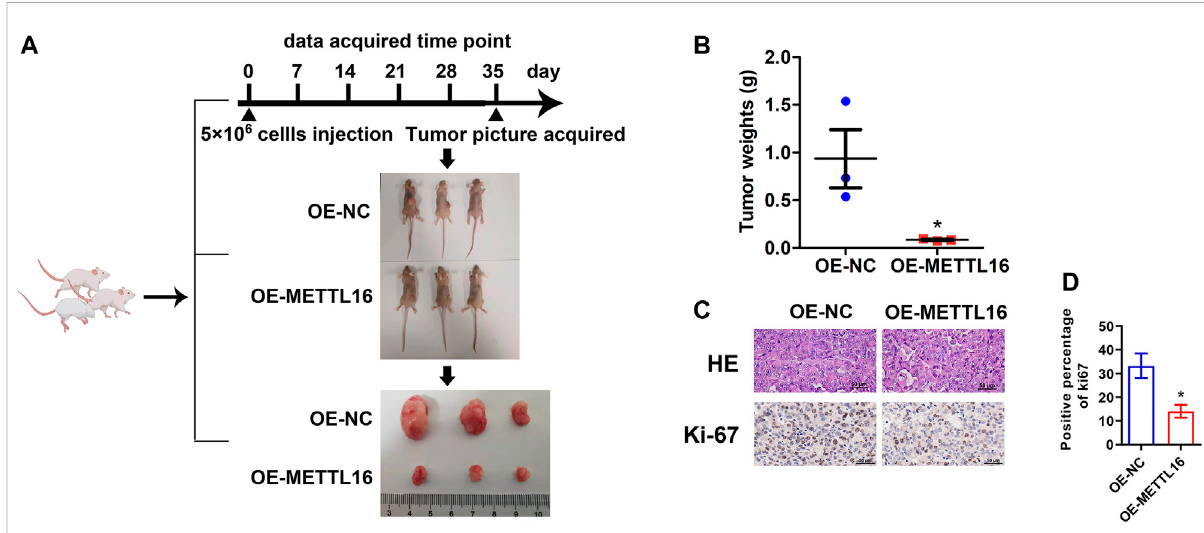
FIGURE 5 Tumor suppressor role of METTL16 in PDA in vivo . (A) Xenograft experiment revealed that enhanced METTL16 expression suppressed the proliferation capacity of MIAPaCa-2 cells. (B) Tumor weights for the overexpression of METTL16 (OE-METTL16) and OE-NC group ( N = 3). (C) Representing immunohistochemistry staining with hematoxylin and eosin and Ki-67 staining. (D) Weaker Ki-67 staining was observed in the OE- METTL16 group than in the control group. Scale bar: 50 µm. Data are presented as mean ± SD. * p <